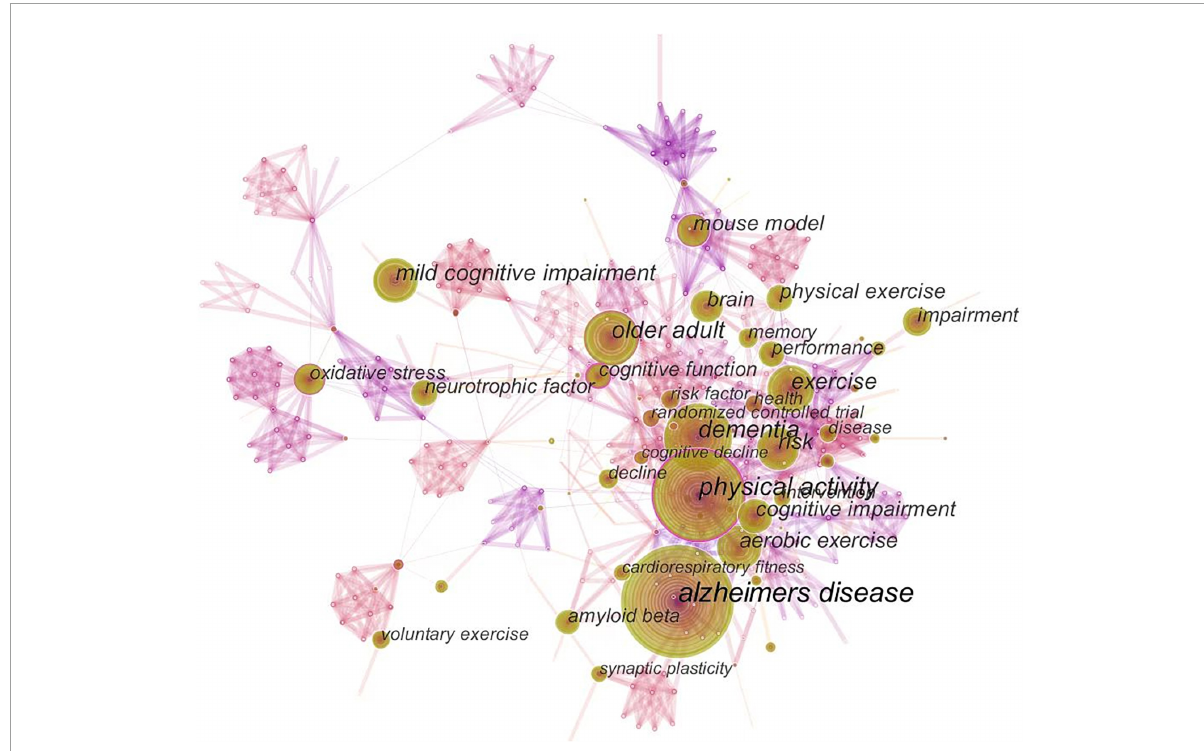
FIGURE5 The map of keywords. The circle size and the link illustrated the frequency and relevance of keywords, respectively.